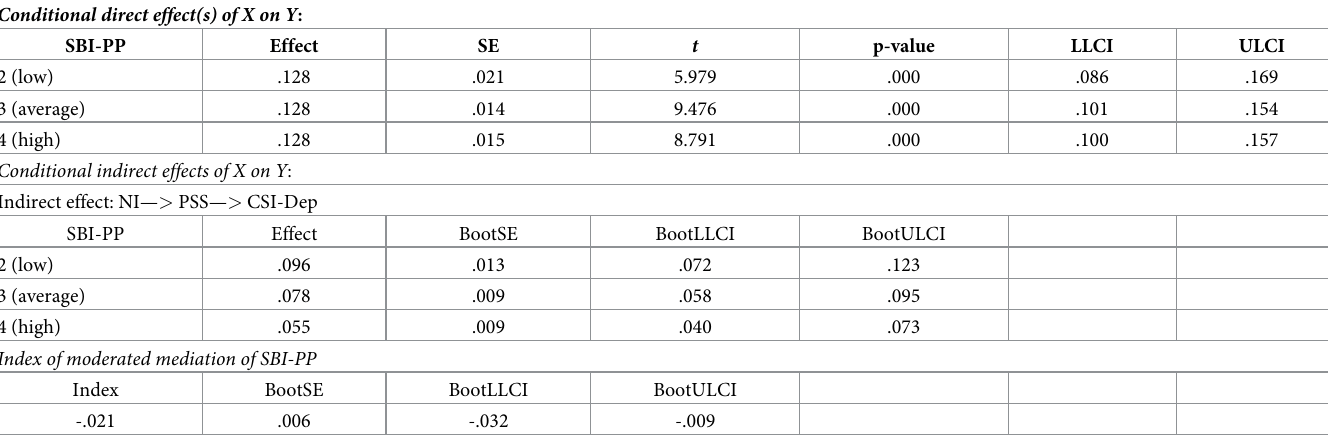
Table 5. The conditional direct and indirect effects of X on